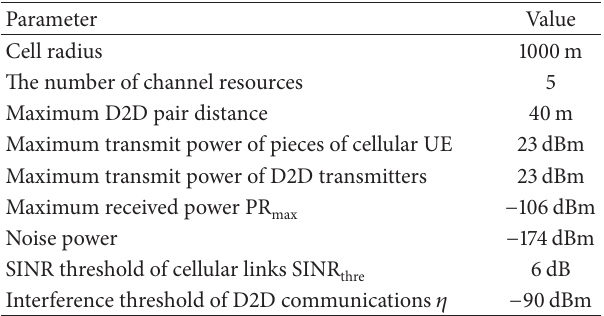
Table 1: Parameters for simulation.